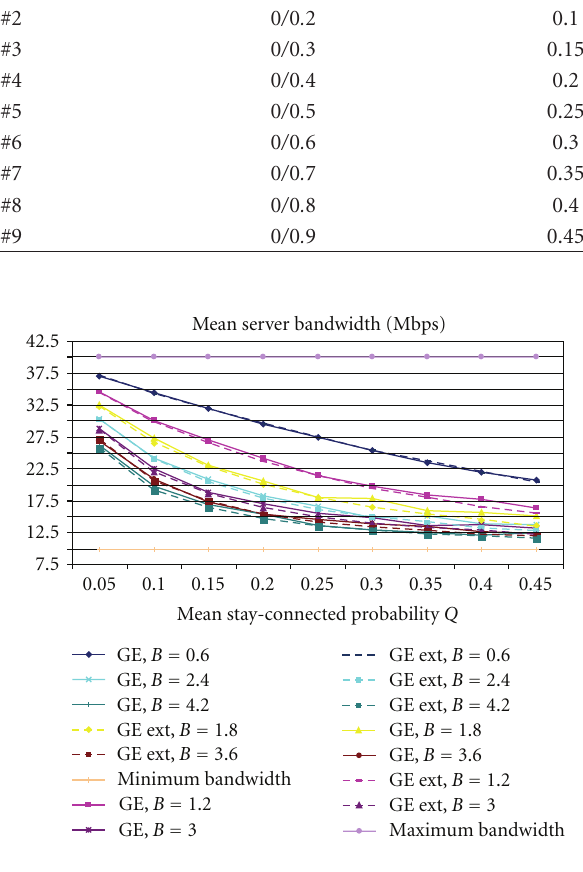
Figure 7: GE models comparison for di ff erent values of bu ff er